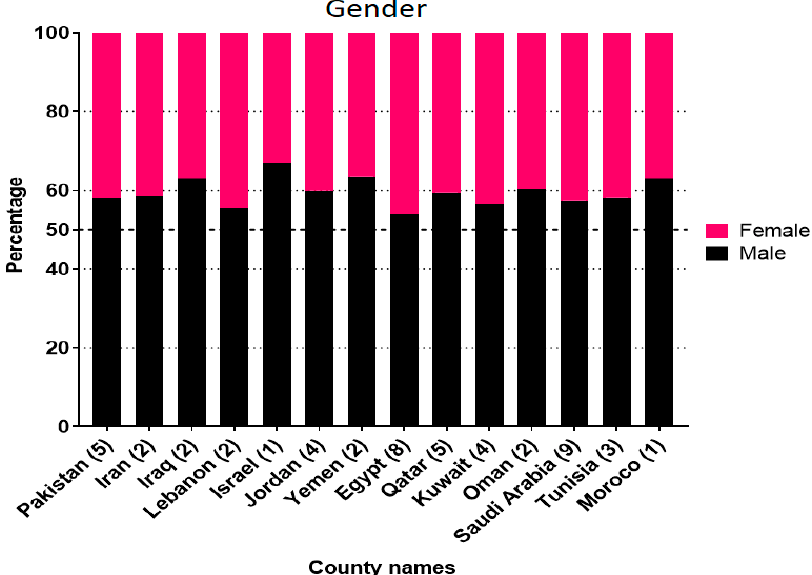
Figure 4. Distribution of Respiratory Syncytial Virus in male and female children.